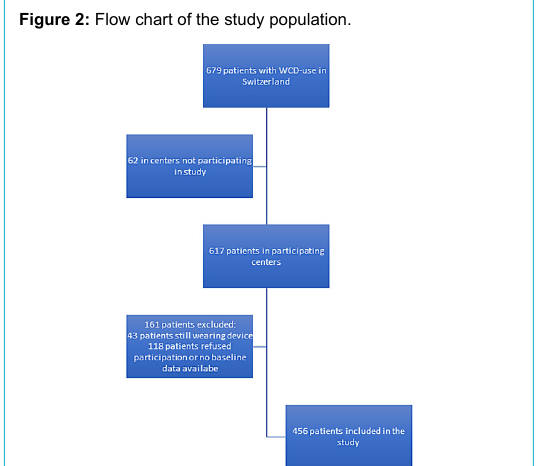
Figure 2: Flow chart of the study population.